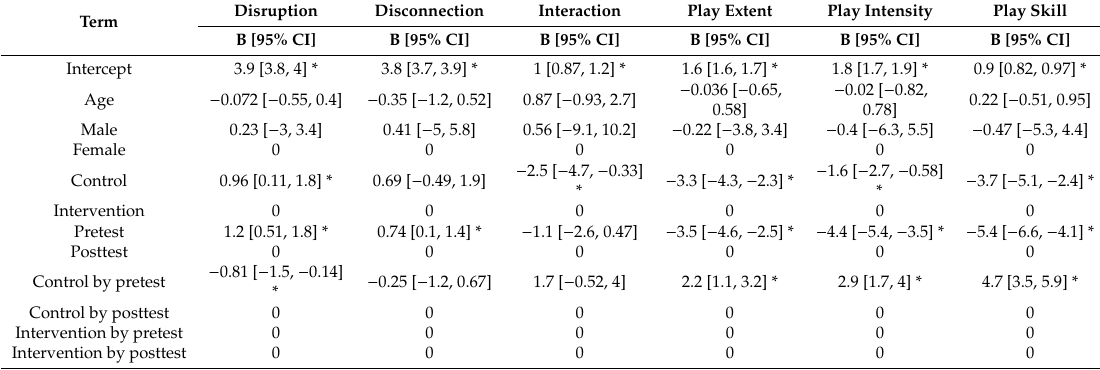
Table 4. Regression coe ffi cients of peer interaction during play and